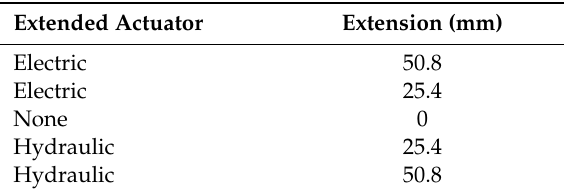
Table 1. Initial o ff set conditions for tandem function evaluation with one actuator set to an initial stroke of 0 mm.